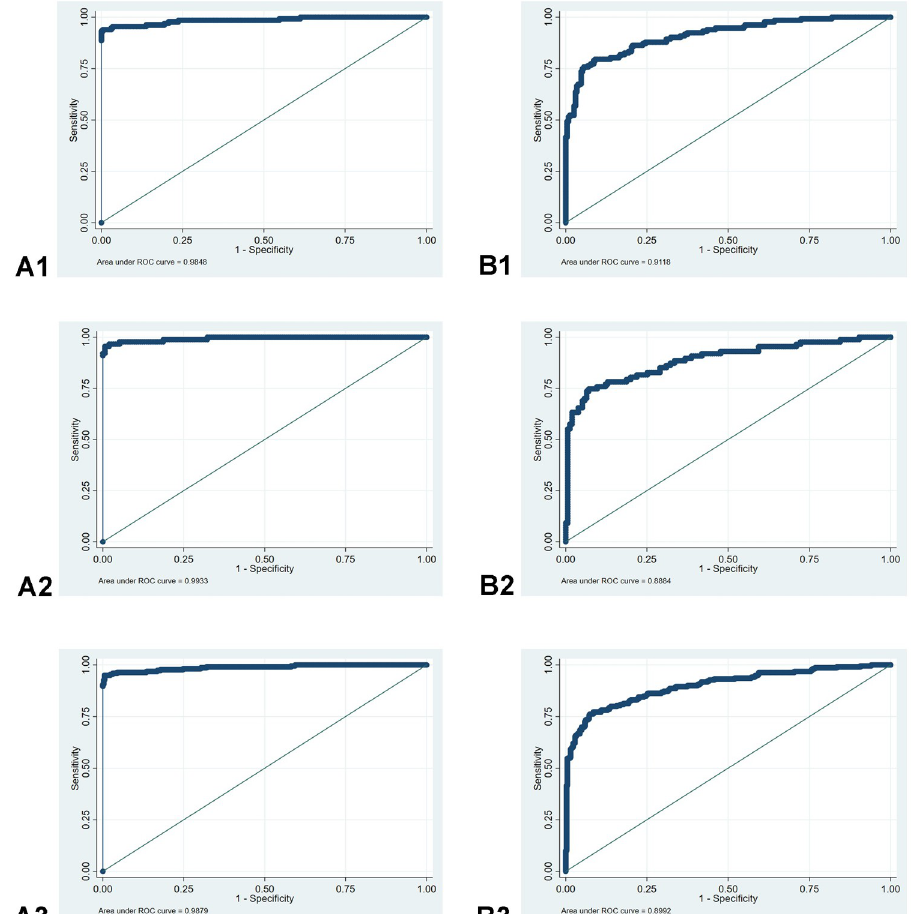
Fig 3. ROC curves-performance of prediction models for scrub typhus as opposed to dengue fever, using M-LR. Panels A1, A2, A3: the variable “eschar” was added into the prediction model; panels B1, B2, B3: “eschar” was not added into the prediction